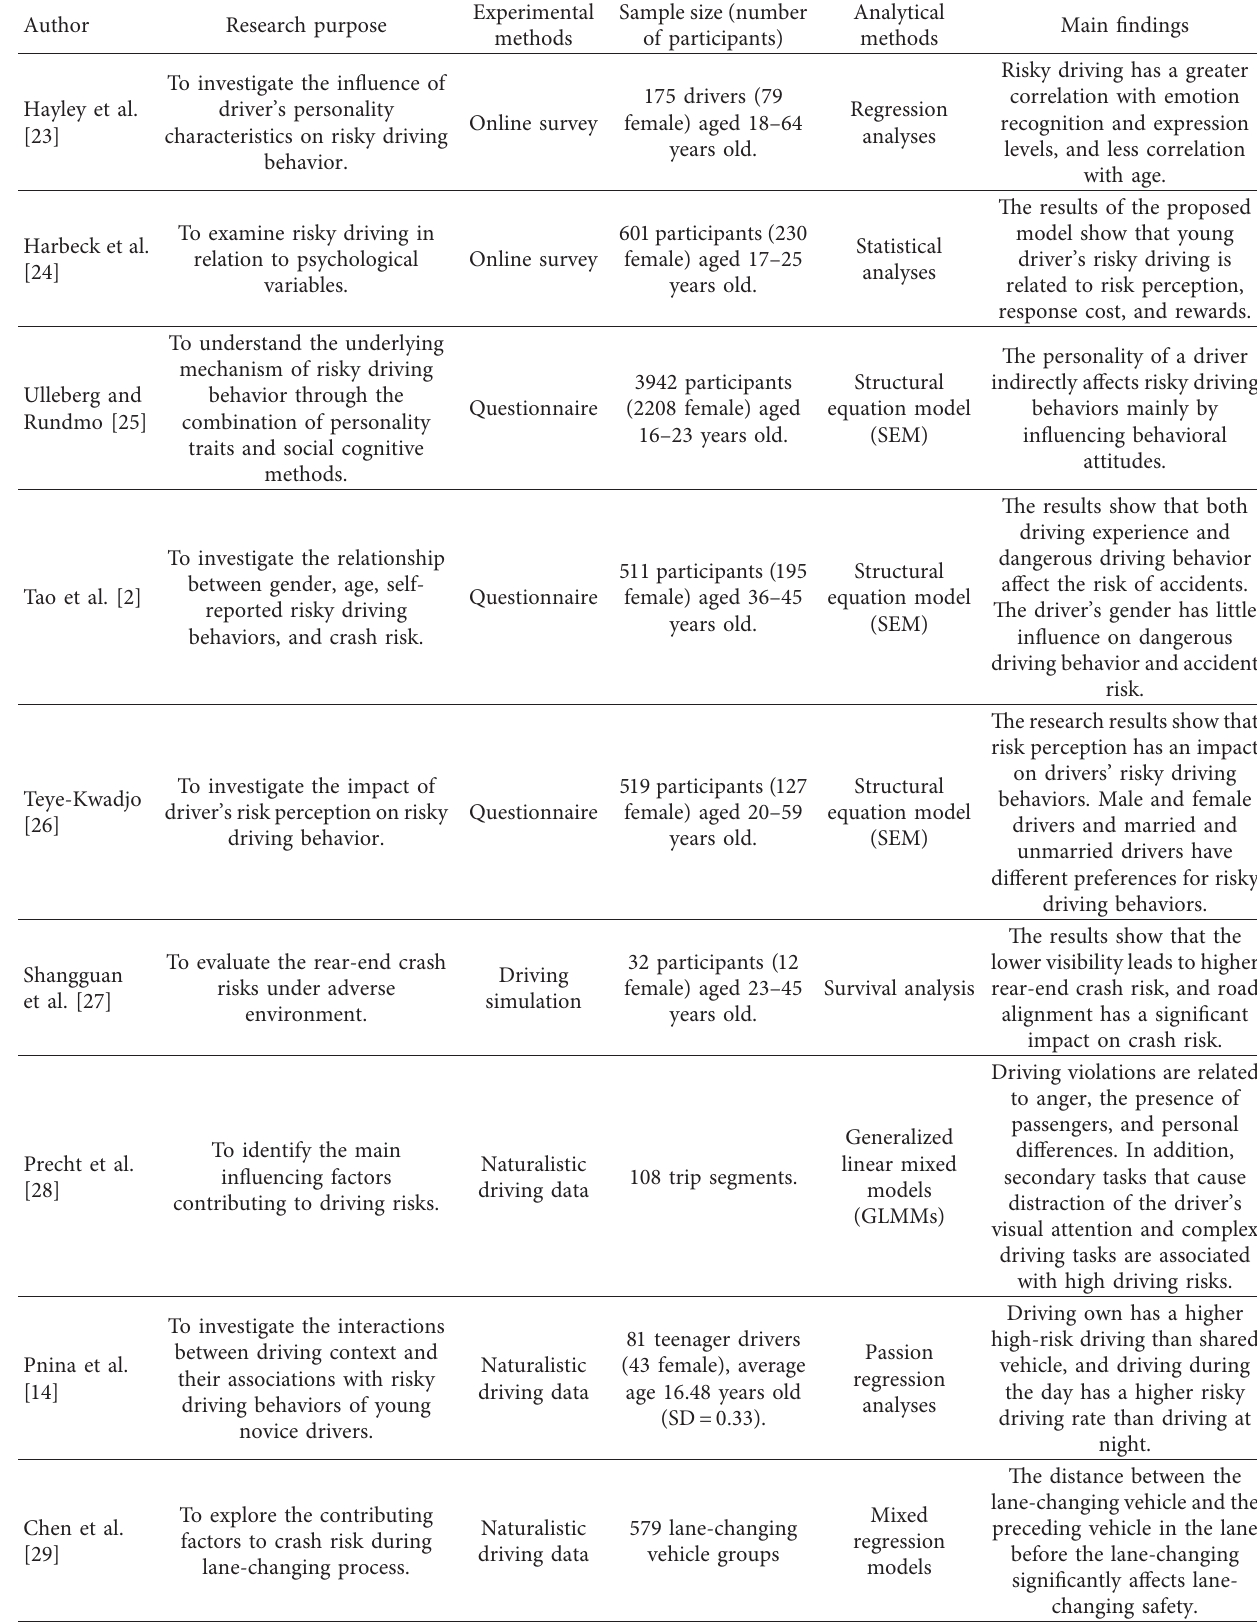
Table 1: Summary of studies on driving risk-related